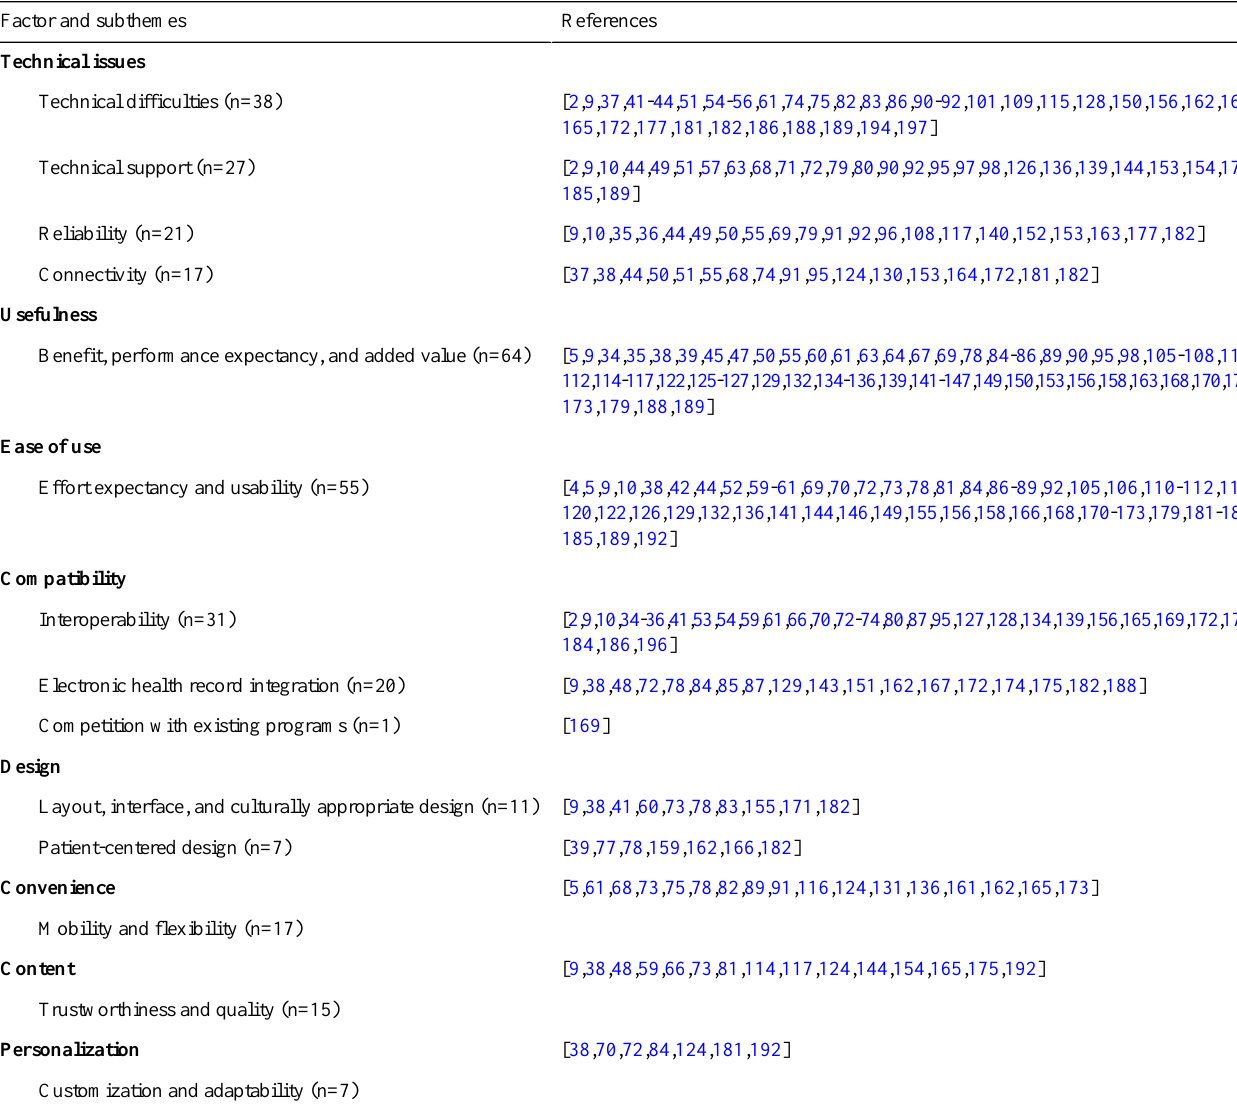
Table 2. Technological factors and their occurrence, with